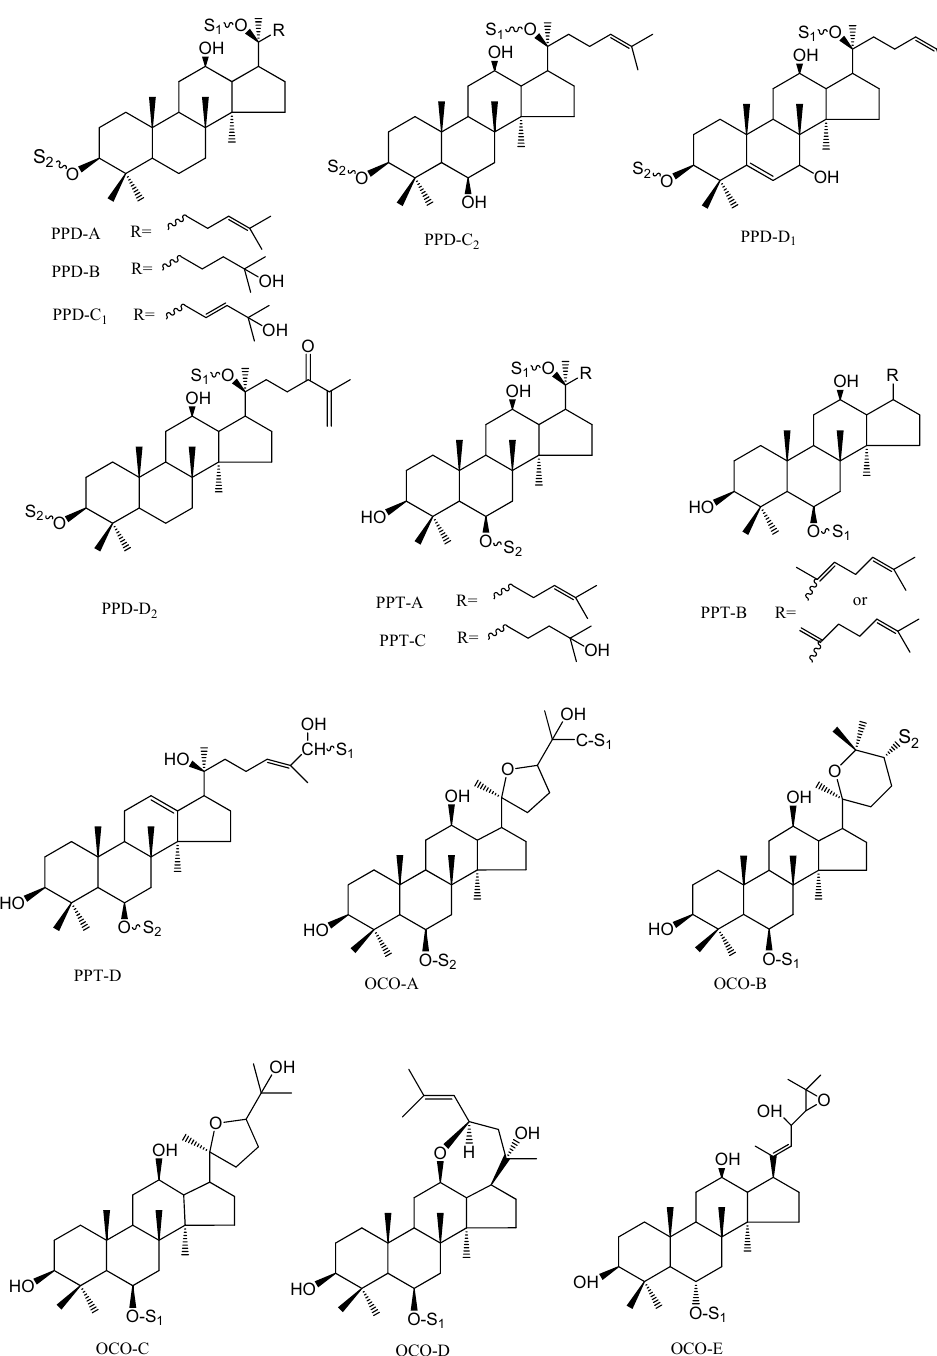
Figure 2. The structures of different types of saponin aglycone.